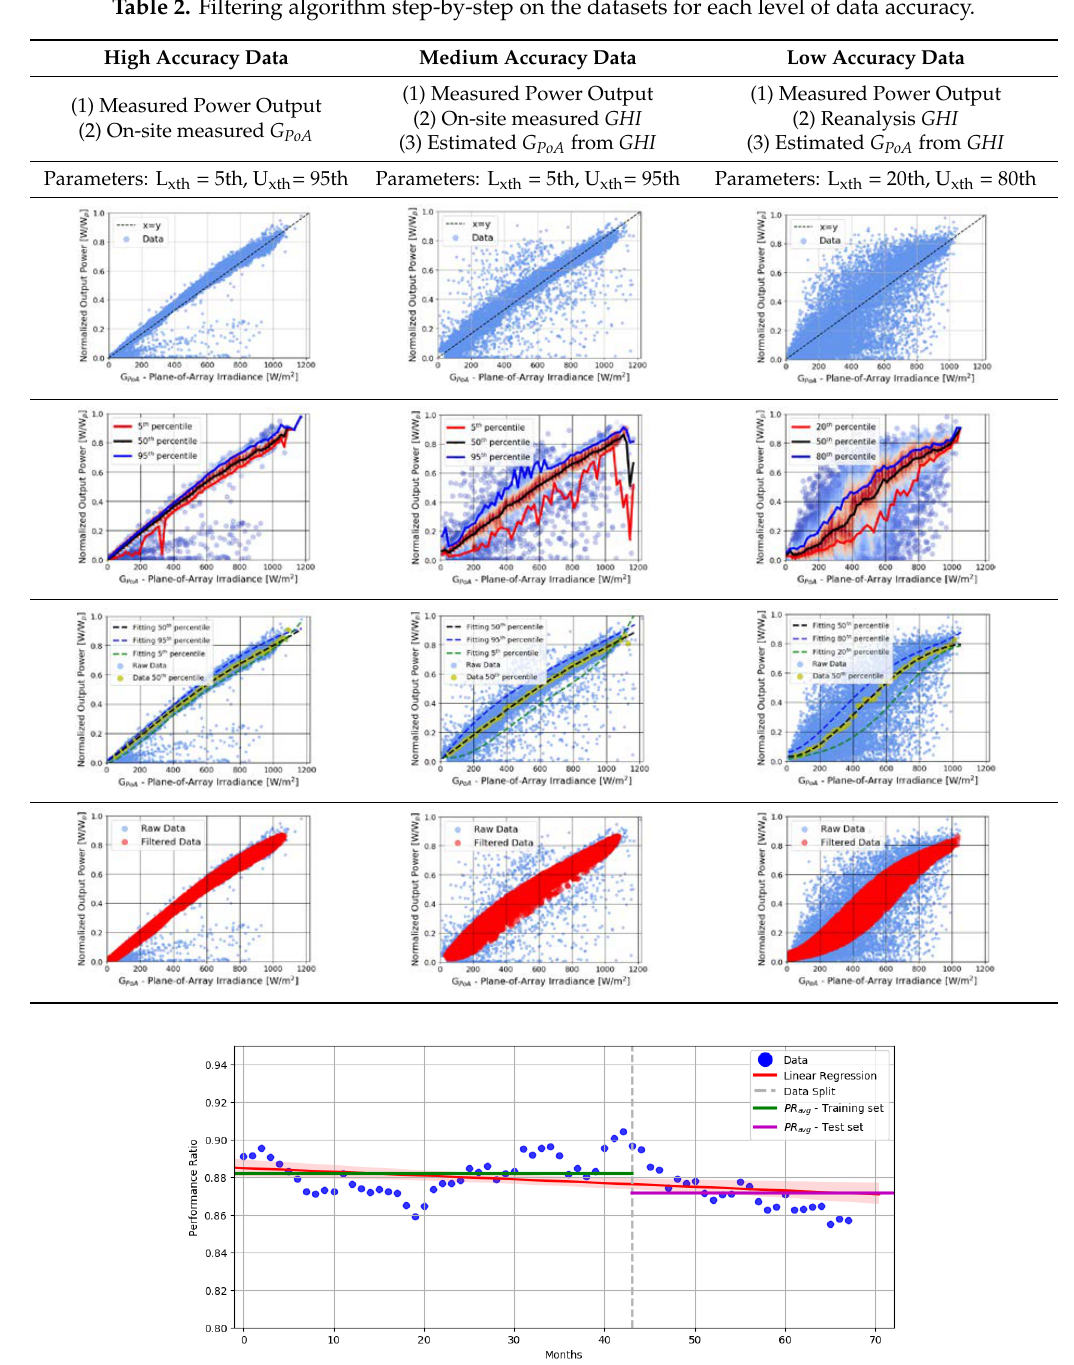
Figure 4. Linear regression of monthly Performance Ratio calculated using the Holt-Winters (HW) seasonal exponential smoothing for the 17-kW PV system in the period May 2014–Dec 2019. The average PR for training set and test set are also